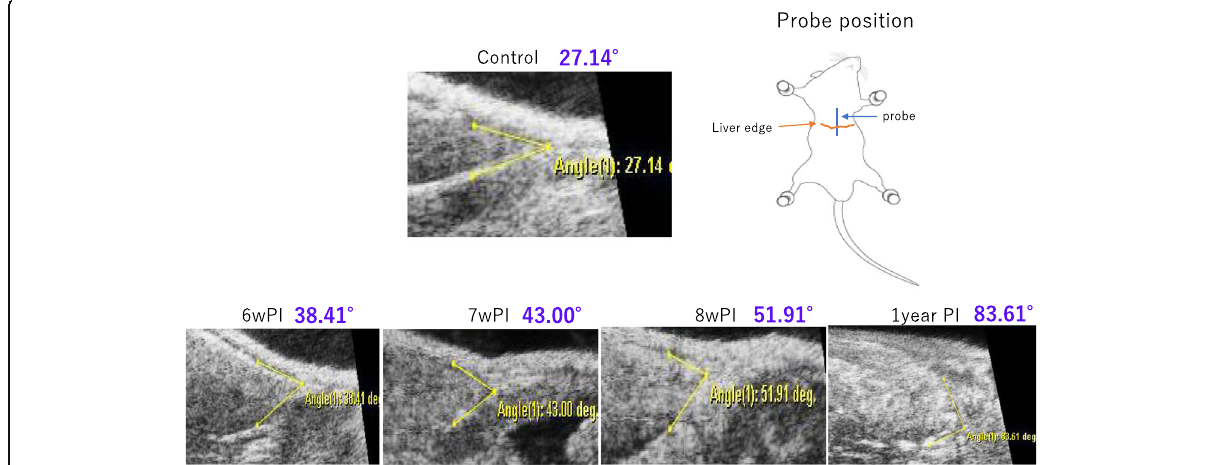
Fig. 4 Angle of the liver edge. The angle of the periphery of the liver became gradually obtuse